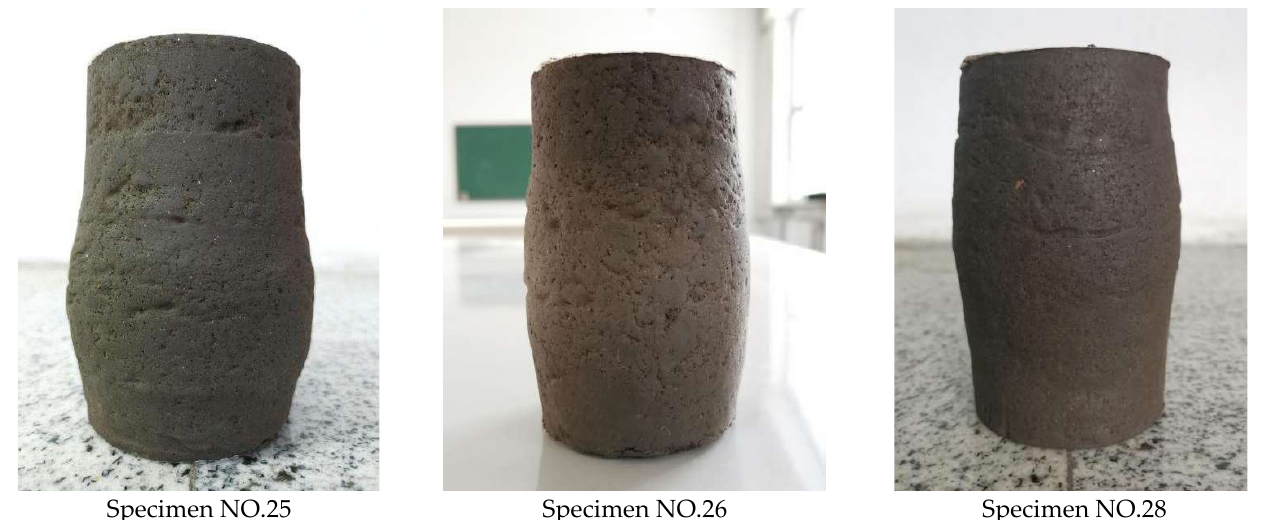
Figure 15. Appearances of tested specimens going through 7 FTHs.